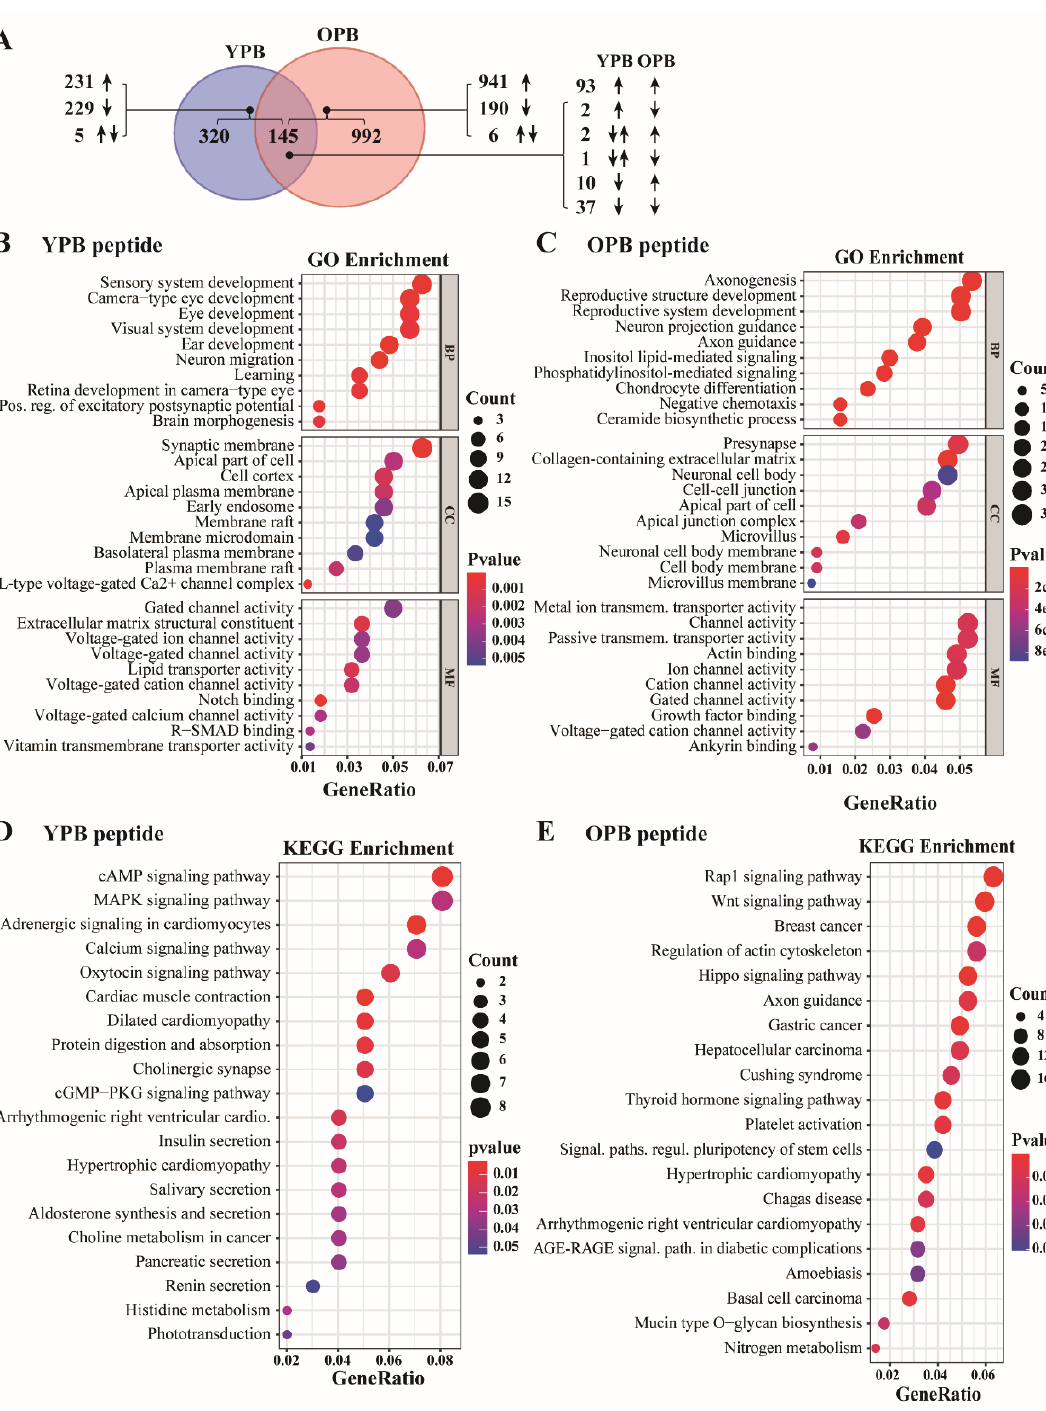
Figure 6. Analyses of the H3K27me3 ChIP-seq data in peptide-treated MDA-MB-231 cells. ( A ) Numbers of genes with altered H3K27me3 ChIP-seq signal in the vicinity ( − 1000 to +1000 bps) of their TSSs when treated by YPB and OPB peptides, and their overlapped genes. The false discovery rate (FDR) was set as <0.05 and the threshold for the fold of change (FC) of H3K27me3 signal was 1.5. The upward and downward arrows designate the genes with increased or decreased H3K27me3 signal, respectively. The genes with both upward and downward arrows indicate that the genes have both increased and decreased H3K27me3 signal in their vicinity. ( B,C ) The top 10 GO terms of the GO analyses of the ChIP-seq data in MDA-MB-231 cells treated by YPB ( B ) and OPB ( C ) peptides. The analyses included biological process (BP), cell component (CC), and molecular function (MF) categories. ( D , E ) KEGG pathway enrichment analyses of the ChIP-seq data in MDA-MB-231 cells treated by YPB ( D ) and OPB ( E ) peptides.